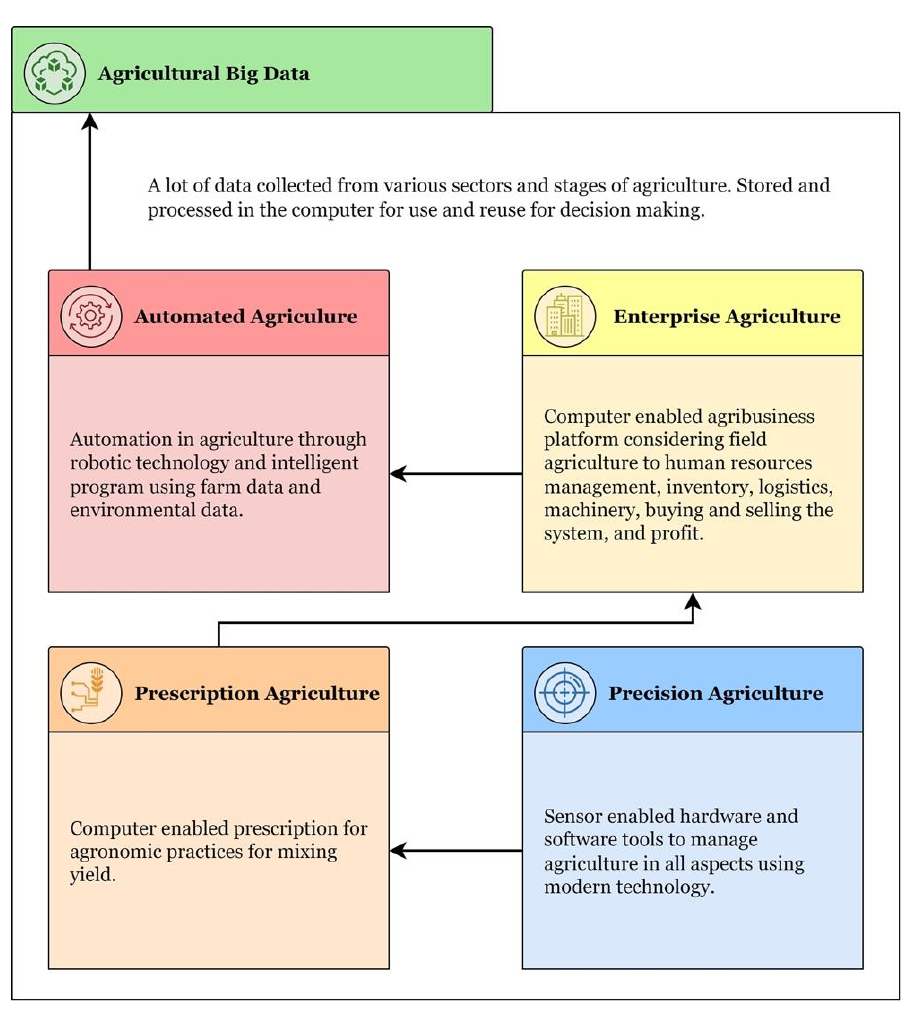
Figure 5. General architecture of Big Data.